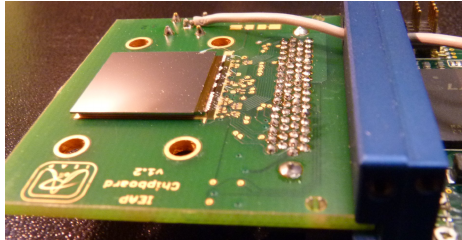
Figure 2. Detail of the Timepix sensor [6].